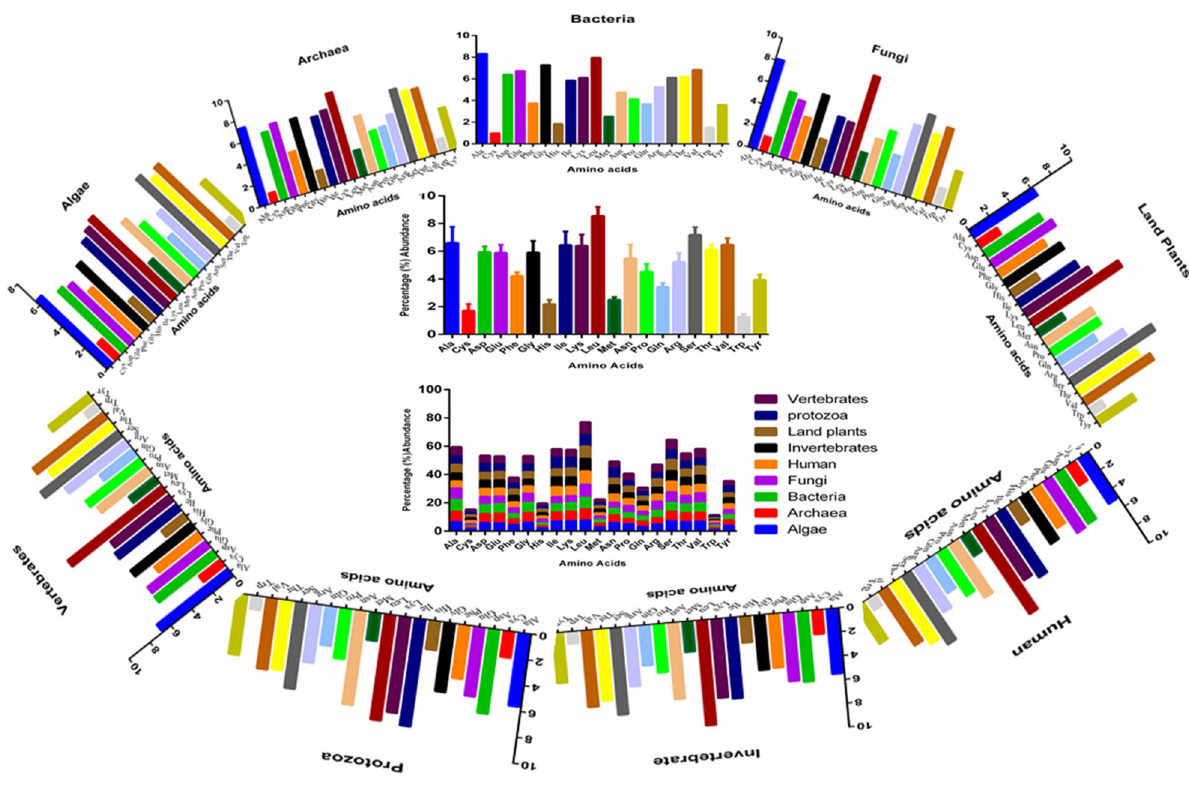
Figure 2. Host-specific amino acid composition of the virus proteome. It was found that Leu (8.556%) was highest and Trp (1.274%) was the lowest abundant amino acid of the virus kingdom. The stacked chart represents the amino acid composition percentage share of virus proteome originated from different hosts. The graphs were generated using GraphPad Prism version